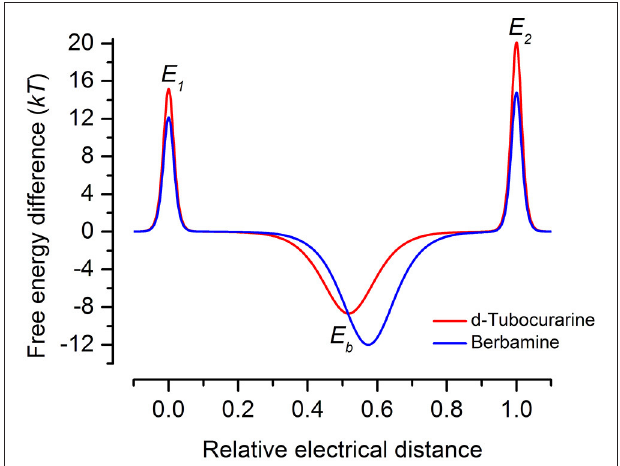
FIGURE 12 | Energy profiles for MET channel permeation and block by extracellular d-tubocurarine and berbamine. Energy profiles calculated from fits to the fractional-block curves and kinetics of MET current block are shown. Values for the free energies of the binding site E b and barriers E1 and E 2 are shown in the absence of a voltage across the membrane ( V m = 0 mV). The voltage-independent extracellular barrier E 1 , at an electrical distance of zero, has a free energy of 15.16 kT for dTC and 12.14 kT for berbamine. E b is − 8.67 kT for dTC and − 12.0 kT for berbamine. The binding sites, δ b , are located at an electrical distance from the extracellular side of 0.52 for dTC and 0.57 for berbamine. The intracellular barrier E 2 , positioned at an electrical distance of one, is 20.13 kT for dTC and 14.82 kT for berbamine.